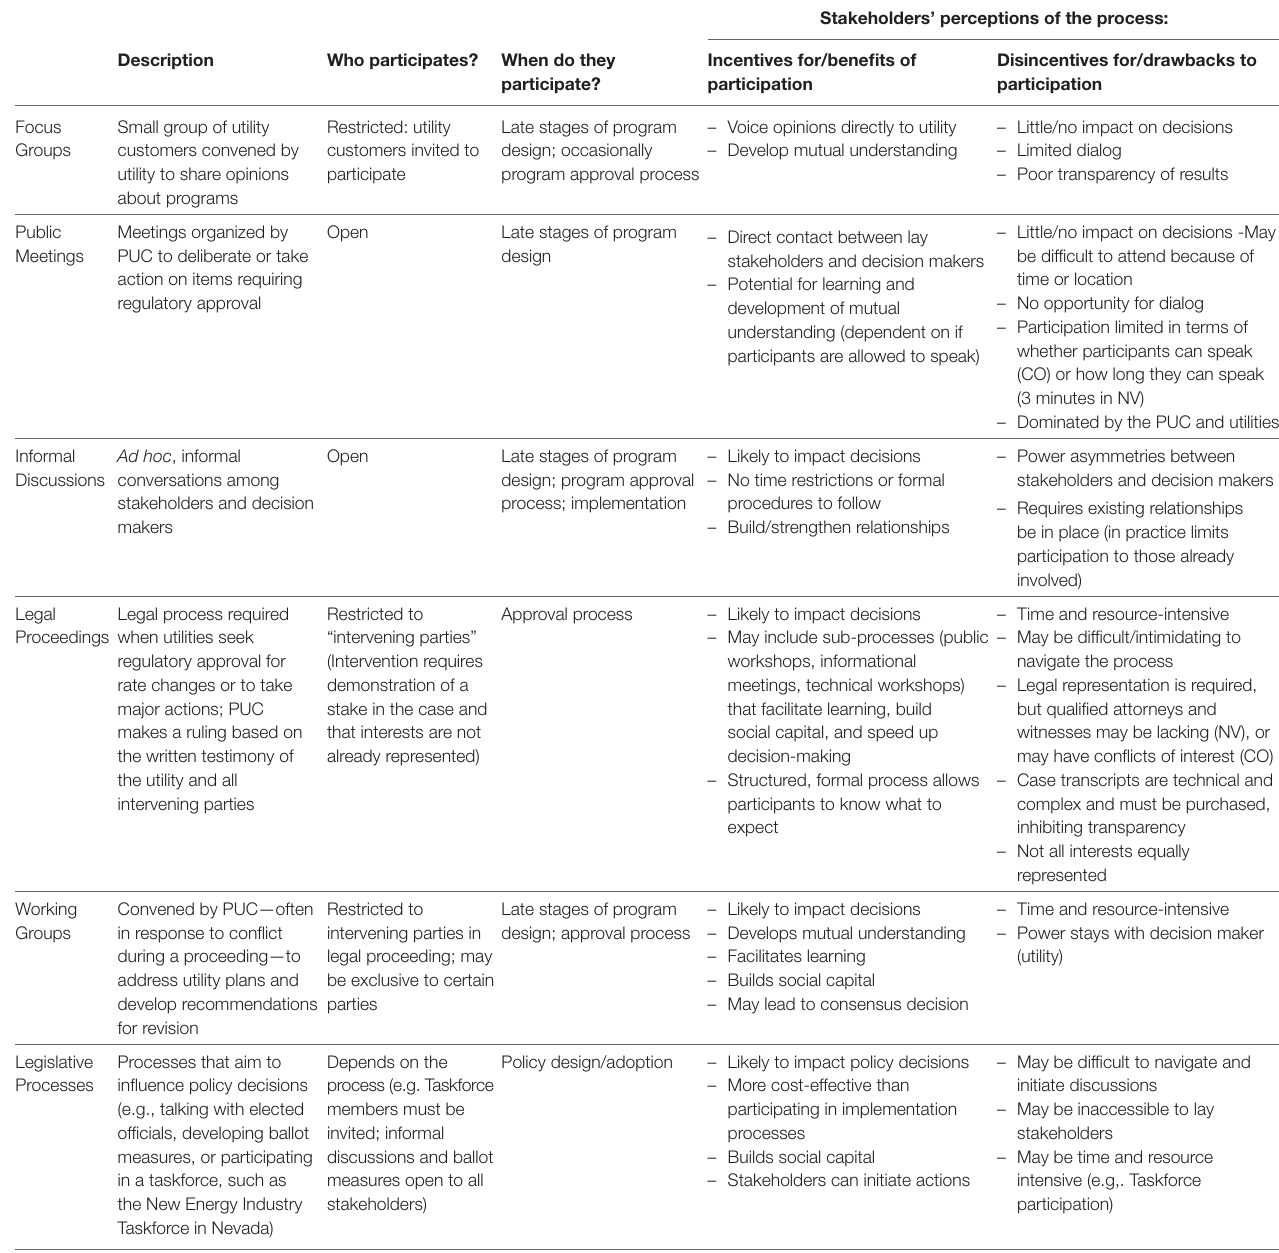
TaBle 1 | Mechanisms and incentives for stakeholders’ participation in RPS policy